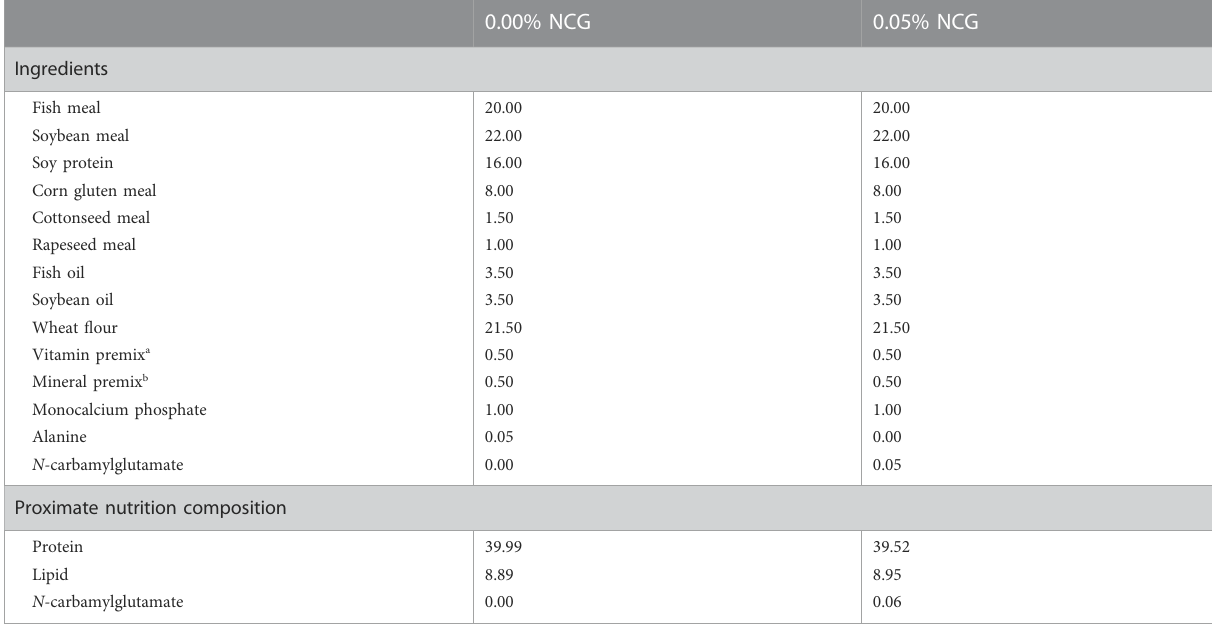
TABLE 1 The formula and approximate composition of the diets used in the experiment (% dry matter basis,